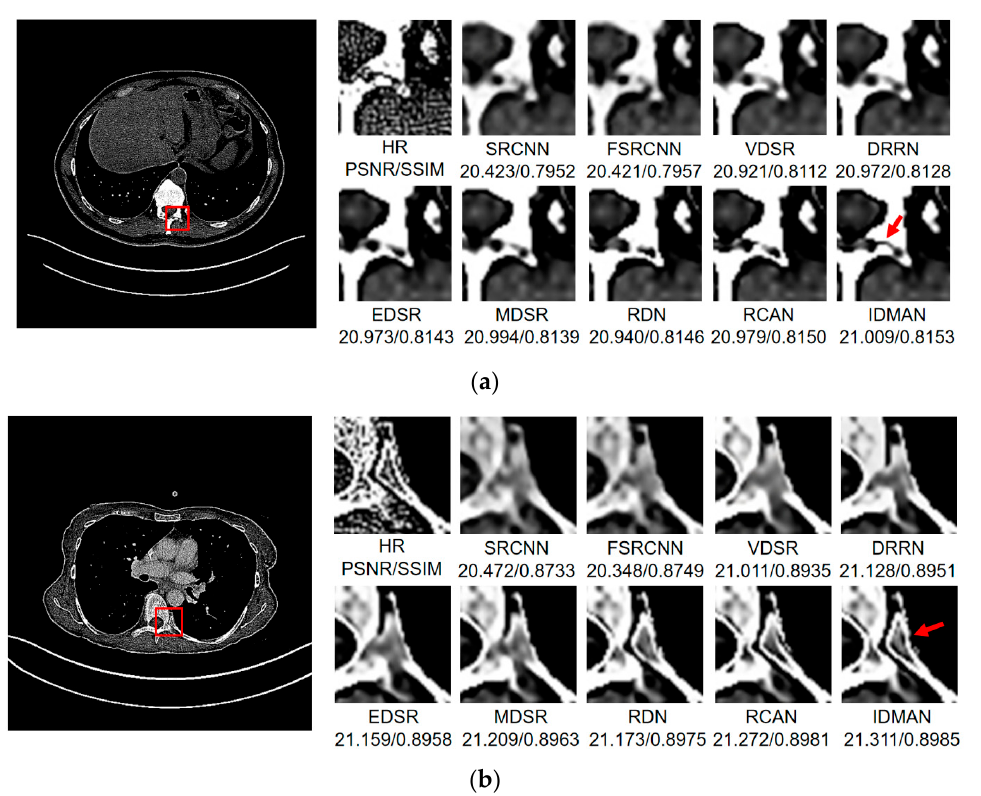
Figure 8. Images ( a – d ) show the visual results of different algorithms on DeepLesion testing set for scaling factor × 2 .